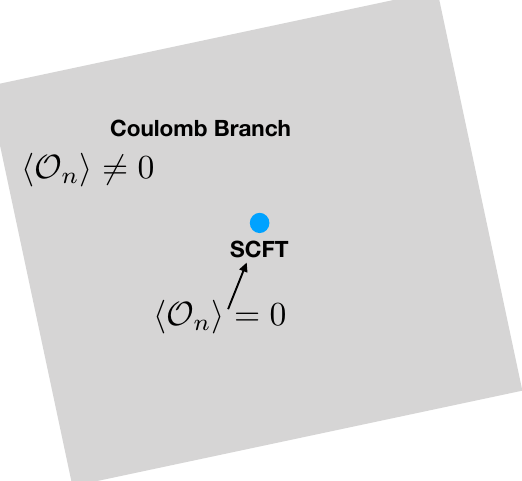
Figure 1 . Structure of the moduli space of Coulomb branch vacua. The grey area, where the u (1) R and conformal symmetries are spontaneously broken, is parametrized by non-zero VEVs of Coulomb branch operators O I